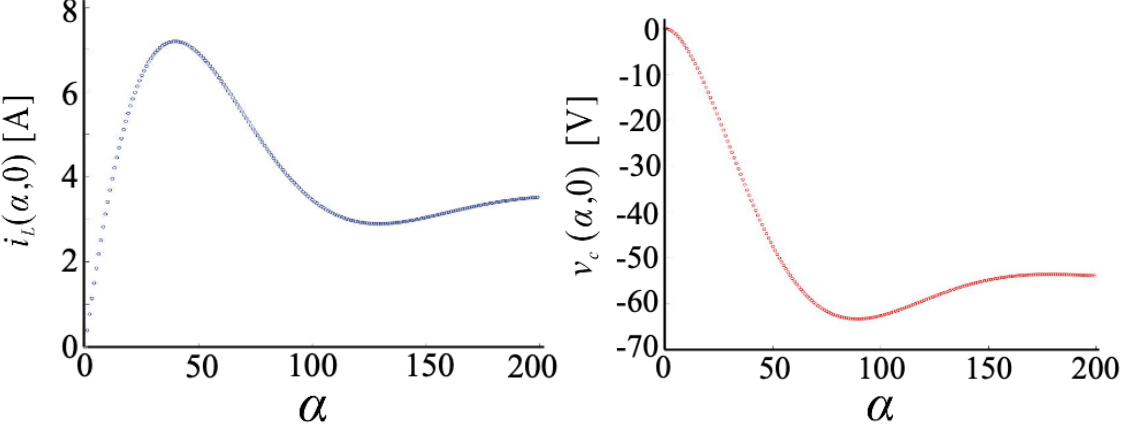
Figure 7. Graph of the ICCV at the beginning of the α -th switching period from S 3 . parameters through analytical Equations (33) and